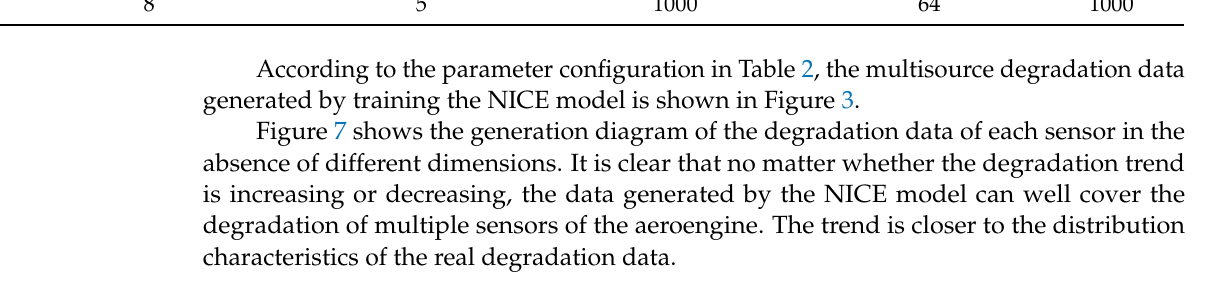
Table 2. NICE model parameters.